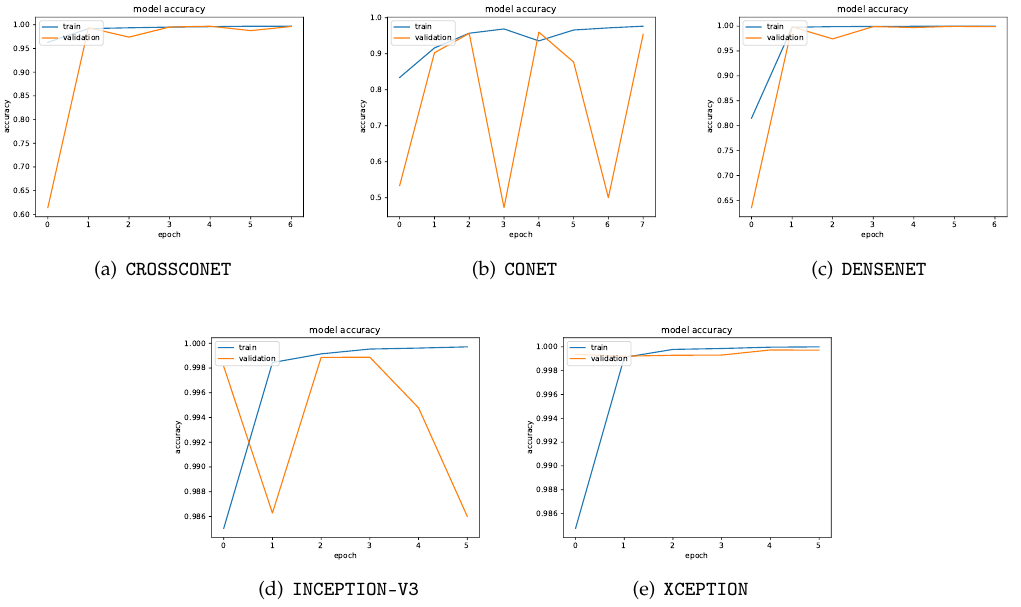
Figure 8. Models of training and validation curves when applied to digital